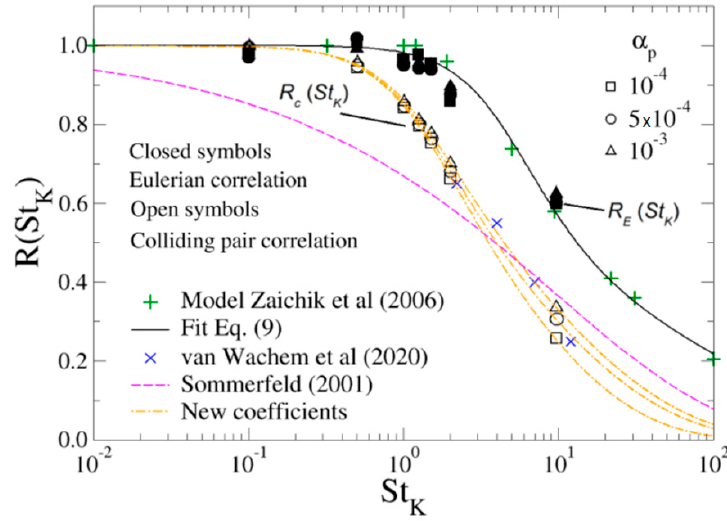
Figure 12. Two-particle velocity correlation function R E ( St K ) . Plus ( + ) symbols represent the results obtained by solving the Zaichik and Alipchenkov model [18]. Cross ( × ) symbols show the results of Reference [28]. Correlation of Reference [30], Equation (6), corresponds to the purple dashed line. The rest of the symbols refer to the LBM-based DNS results obtained in this work for di ff erent average volume fractions. Closed symbols represent the Eulerian correlation evaluated at a distance r = 3 d p /2, Equation (9), and open symbols represent the obtained colliding pair velocity correlation, Equation (10) (see text for details). The dot-dashed lines fit the colliding two-particle velocity correlation functions, R c ( St K ) , of the di ff erent volume fraction cases studied in this work.